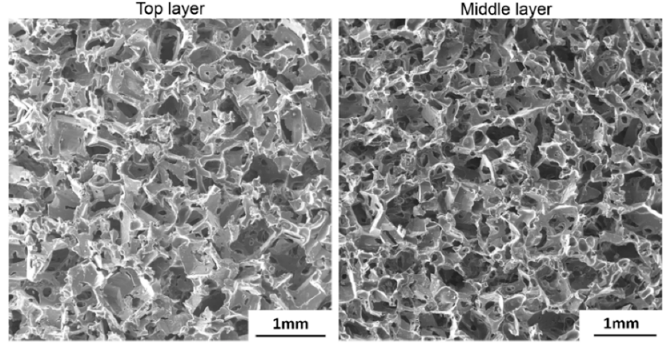
Figure 4. SEM images taken from the top layer and the middle layer of the porous SMP foam fabricated using the sugar particle leaching method, showing the open-cell structure of the foam.